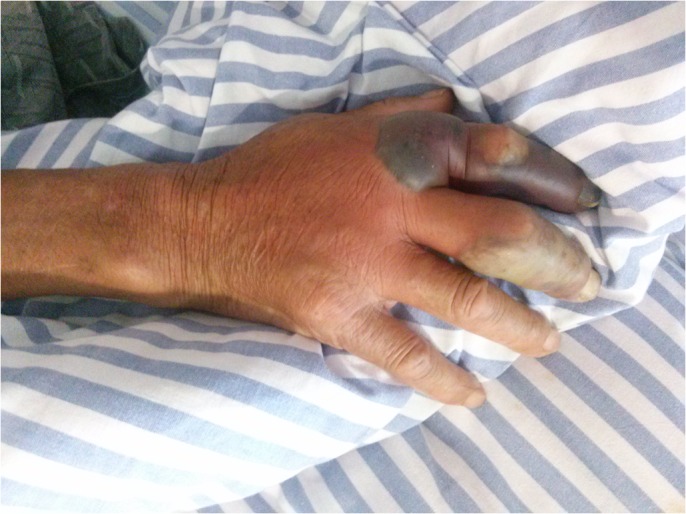

V. vulnificus infection that presented as swelling, Hemorrhagic bulla and phlegmon are observed on the right hand.